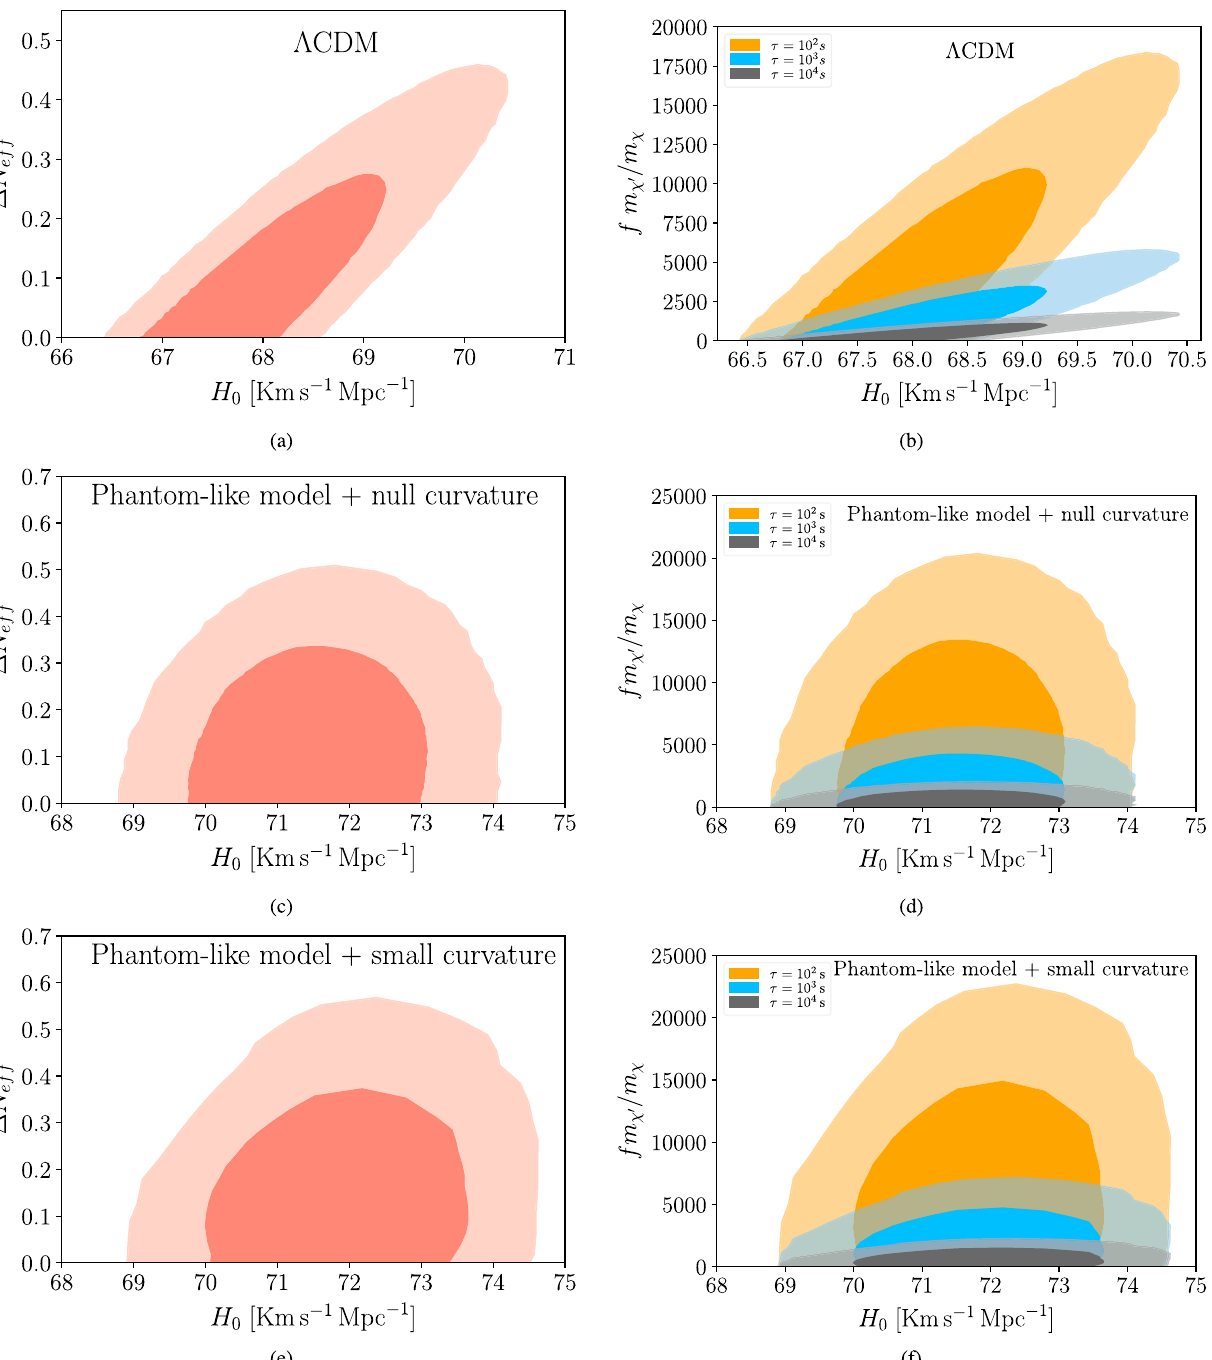
(cid:9) N ef f and H 0 showed in a , c , e is taken from [11]. In all figures, the lighter regions correspond to 99% of CL, while the darkest regions cor- respond to 68% of CL. In b , d , f the orange, blue and gray regions correspond to the cases where χ (cid:4) lifetime is 10 2 s, 10 3 s and 10 4 s respectively. The bounds use Planck 2018 CMB data, BAO, and type Ia data from the Pantheon